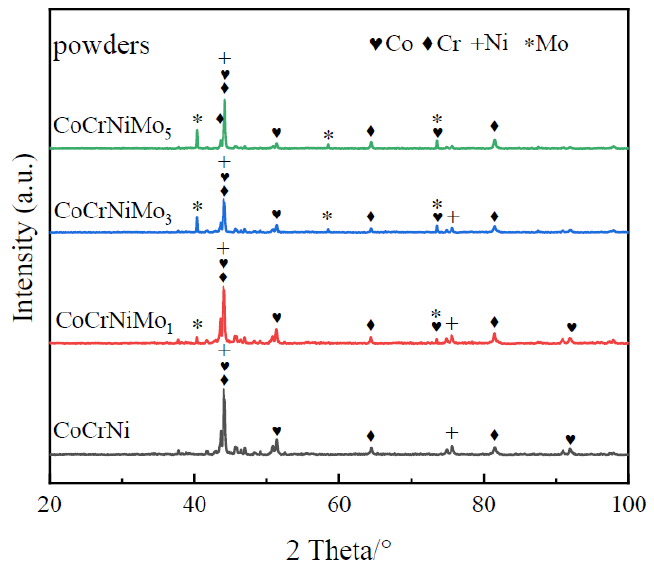
Figure 2. XRD patterns of CoCrNiMo x powders after ball